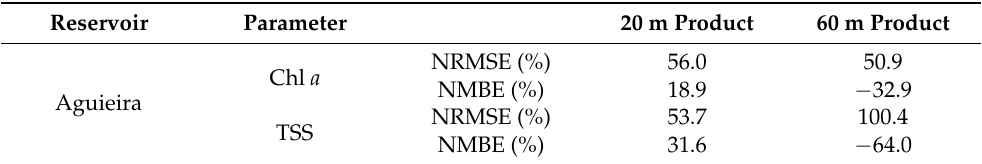
Table 4. Normalized root mean squared error (NRMSE) and the normalized mean bias error (NMBE) results for Aguieira, without observations from spring of 2020.